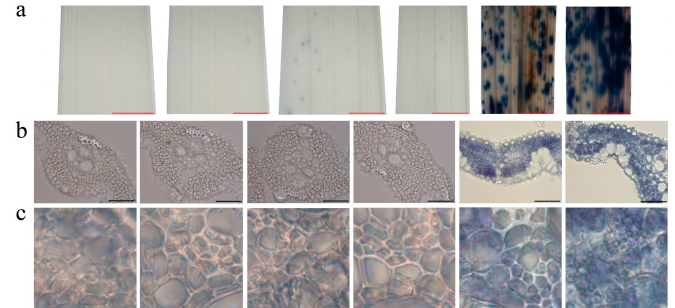
Figure 3. Trypan Blue (TB) staining on the leaves of ZJ22 and pir1 sampled at the five-leaf stage. Each set of images represents (from left to right), the flag, 2nd and 3rd leaves of ZJ22, and then the flag, 2nd and 3rd leaves of pir1 . ( a ) Leaf phenotype; red scale bar = 0.2 cm. ( b ) Cell morphology; black scale bar = 50 μ m. ( c ) Magnified cell morphology; green scale bar = 10 μ m.